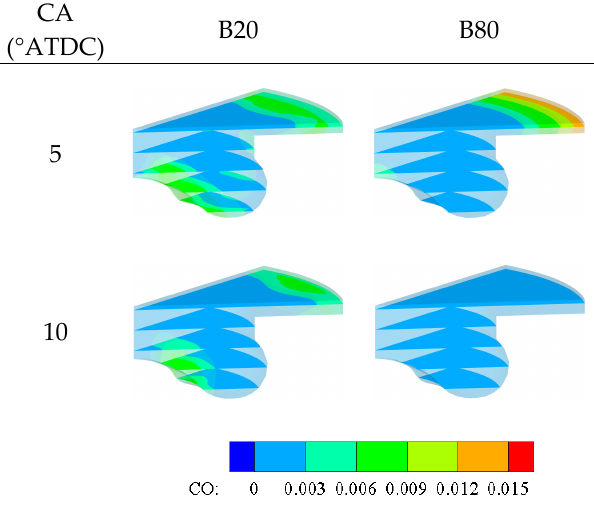
Figure 14. Simulated evolution of spatial CO distributions under conditions of B20 and B80.